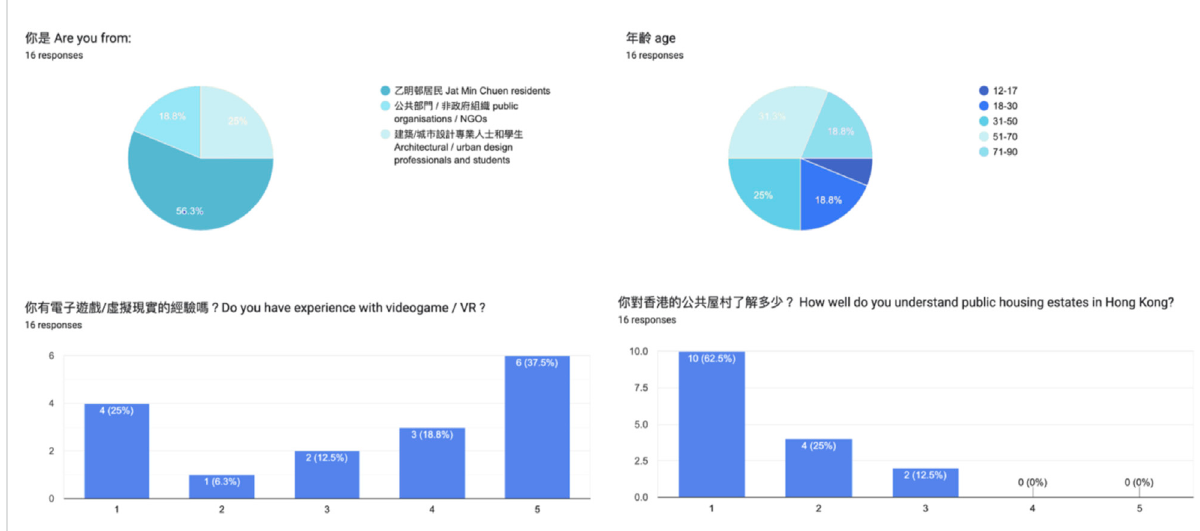
FIGURE 11 Questionnaire results from the sign-up form to map the participant demographics.